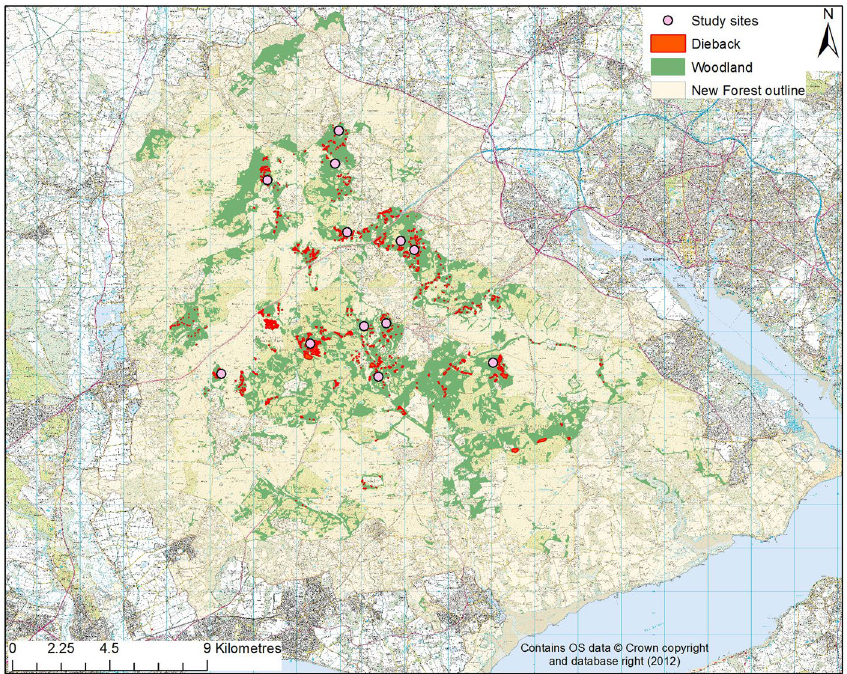
Figure 1. Distribution of broadleaved woodland (green), occurrence of dieback (red) and location of each of the 12 study areas (pink dots) in the New Forest, in southern England. Map was made using ArcMap 10.1